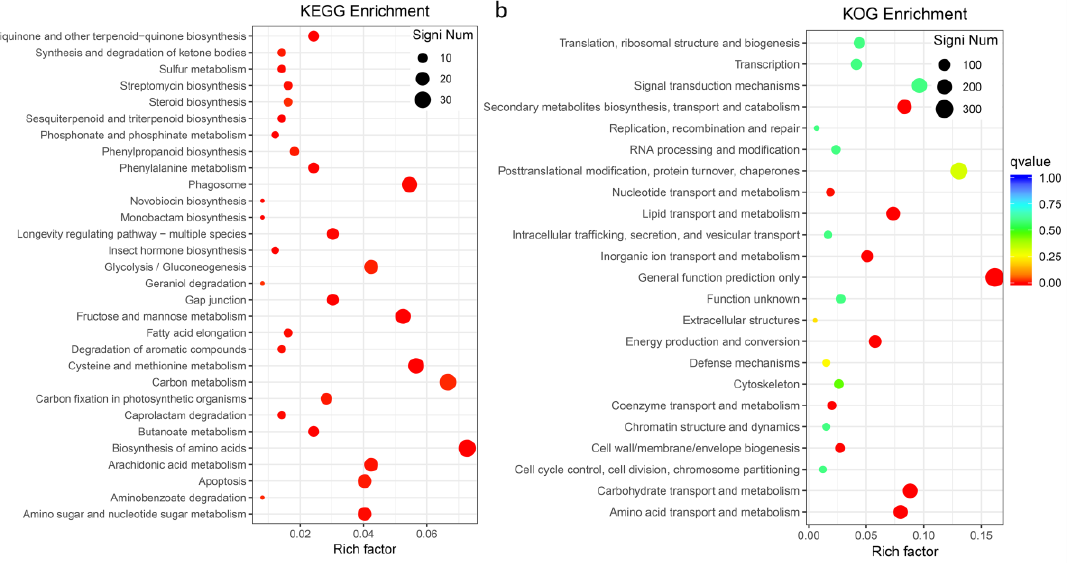
Figure 2. KEGG ( a ) and KOG ( b ) pathway enrichment scatter diagram of DEGs between multifoliate